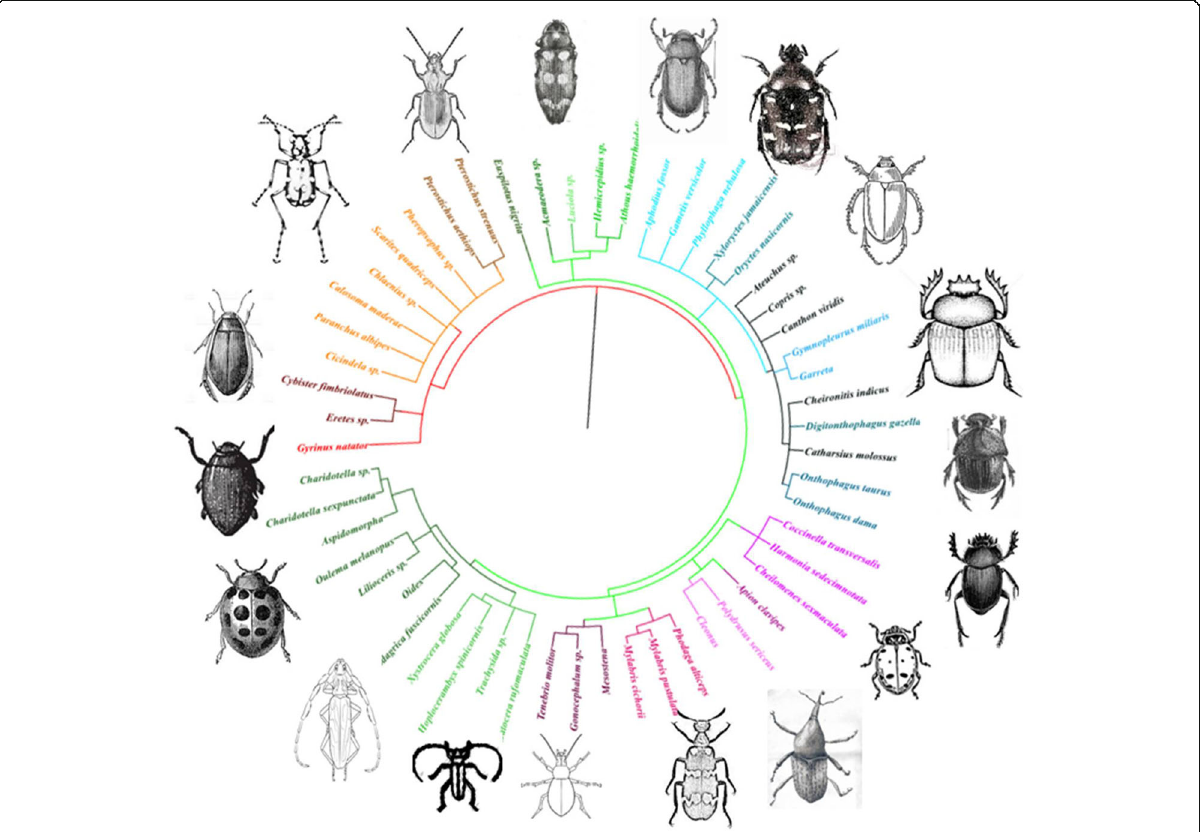
Fig. 8 Circular phylogenetic tree of Coleoptera populations based on maximum likelihood method at level of genus. The line in the center represents the higher taxonomic levels, which includes Kingdom-Animalia, Phylum-Arthropod, and Order-Coleoptera, and coding is according to different taxonomic levels in Polyphaga (12 families) and Adephaga (3 families) both. The tree was constructed in MEGA